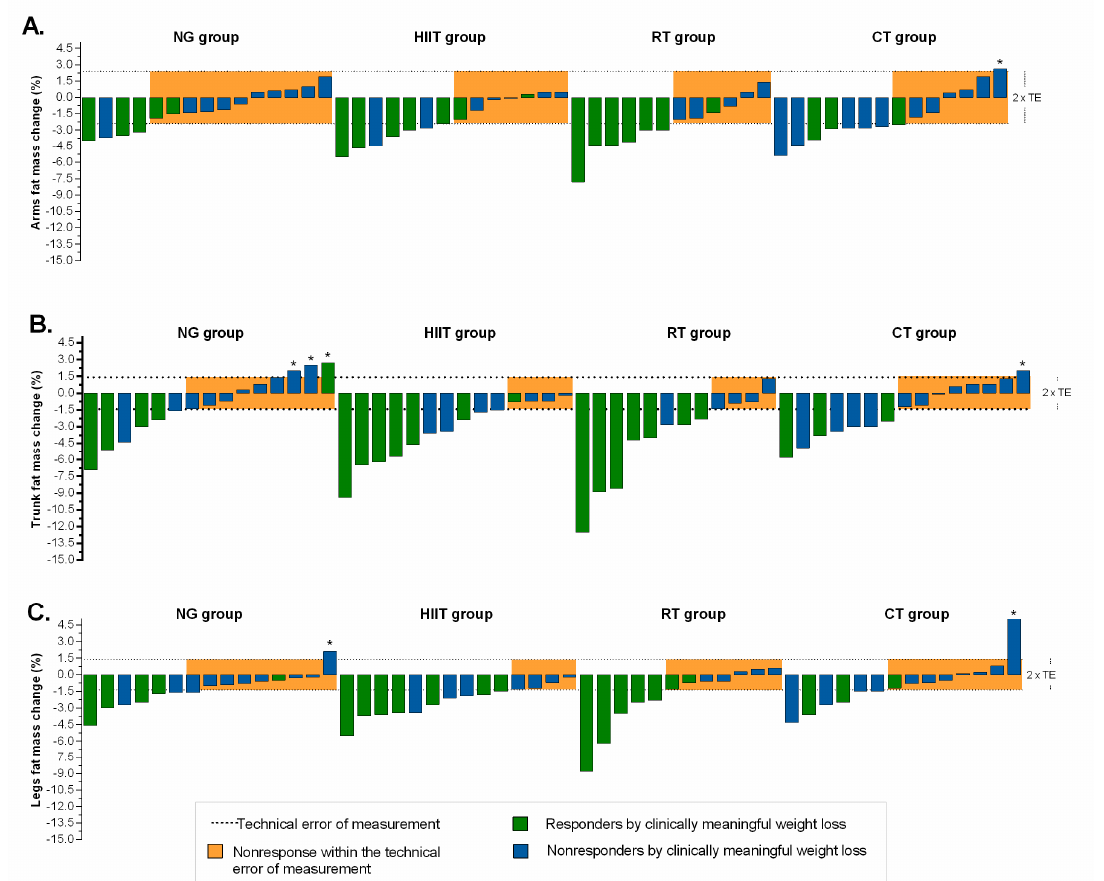
Figure 3. Individual change by intervention group based on fatness indexes. (Panel A ): arms fat mass; (Panel B ): trunk fat mass; and (Panel C ): legs fat mass. The TE for each measurement (see “Methods” section for 2 × TE calculation) is illustrated by the lighter shaded area. Dashed lines represent the TE, while an individual falling within the shaded area would have demonstrated a nonresponse for both variables. Responders by clinically meaningful weight loss ( ≥ 5%) is illustrated by the green bar. Individual changes in blue bar represent nonresponse by clinically criterion weight loss ( < 5%). *Adverse responders (individuals whose fat mass indexes increased by more than 2 × TE). NG: nutritional guidance alone group; HIIT: high-intensity interval training group; RT: resistance training group; CT: combined training (HIIT + RT)